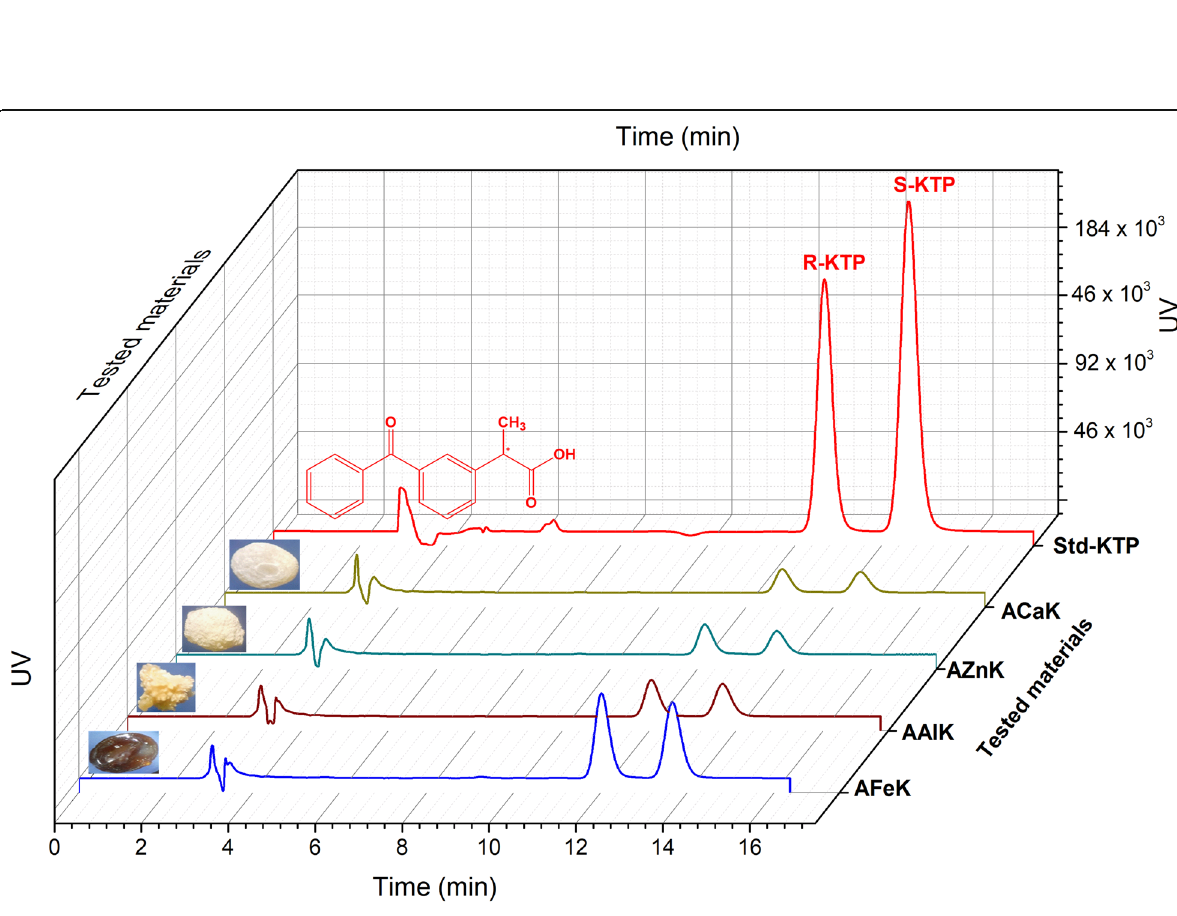
Fig. 6 HPLC chromatograms for mixed beads complexed with Ba (ABaCaK, ABaZnK, ABaAlK, ABaFeK) and mixed beads with Ca and Fe; simultaneous (A 1 K) and consecutive (A 2 K, A 3 K) congealed